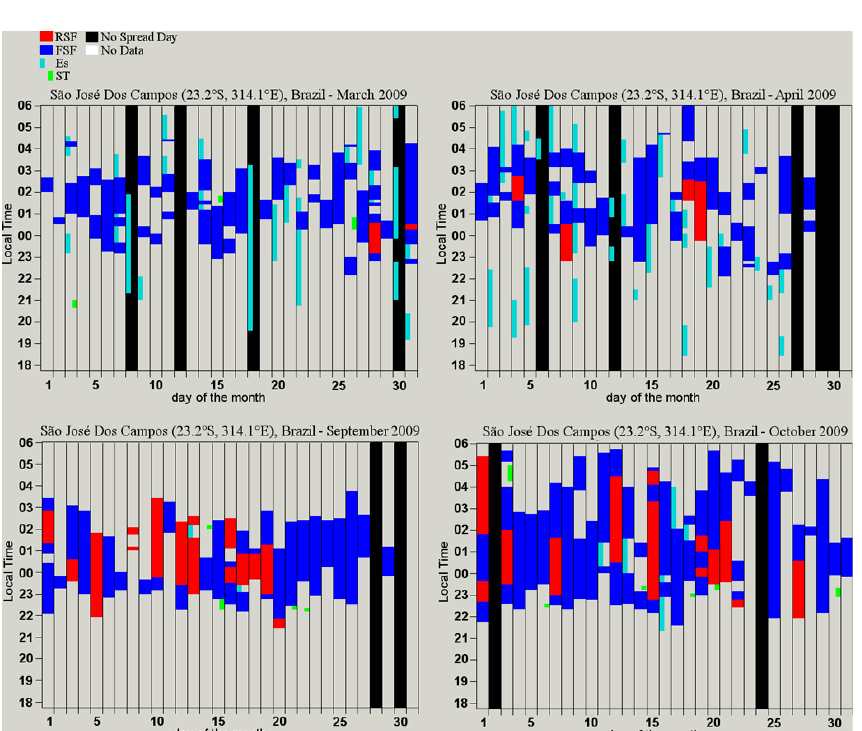
Fig. 8. Same as Fig. 5 for S˜ao Jos´e Dos Campos,